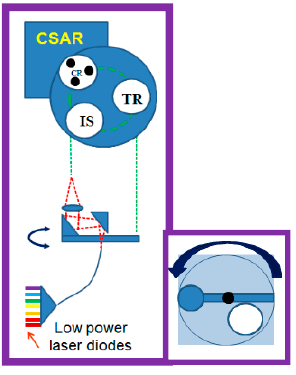
Figure 9. Laser diode (LD) illumination system (schematic).